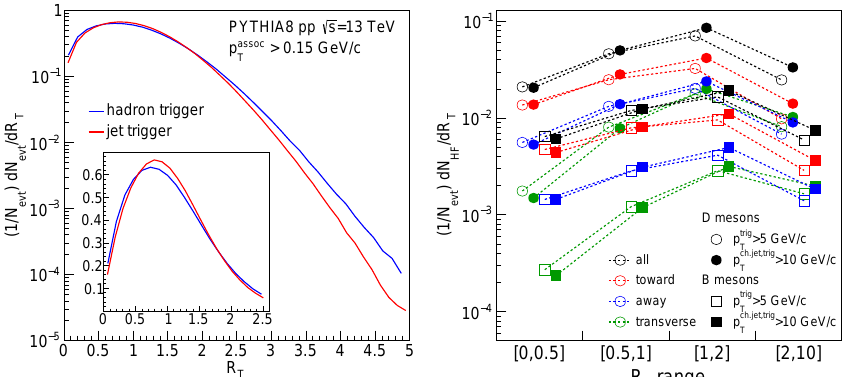
> 5 GeV/ c ) Figure 1. Left : R T probability distributions for events triggered with the leading hadrons ( p trig T > 10 GeV/ c ). The insert shows the same compared to those triggered with inclusive jets ( p ch.jet,trig T distribution on a linear scale. Right : Distributions of heavy-flavour D and B hadrons among the different R T classes in hadron-triggered as well as in jet-triggered events, shown for the full event as well as for the toward, transverse and away regions separately. (The dashed lines are to guide the